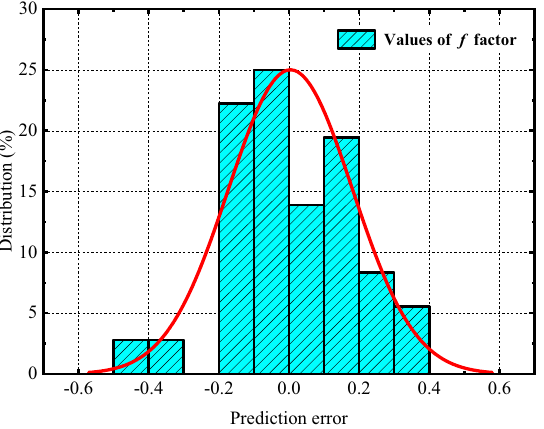
Figure 10 Absolute error distributions of f factor prediction